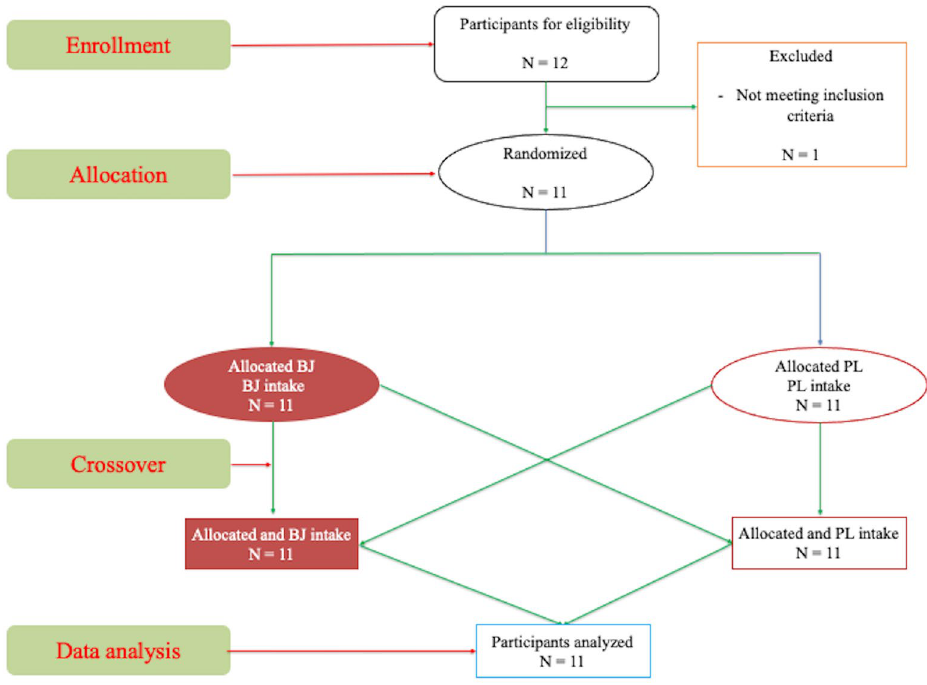
Figure 1. CONSORT